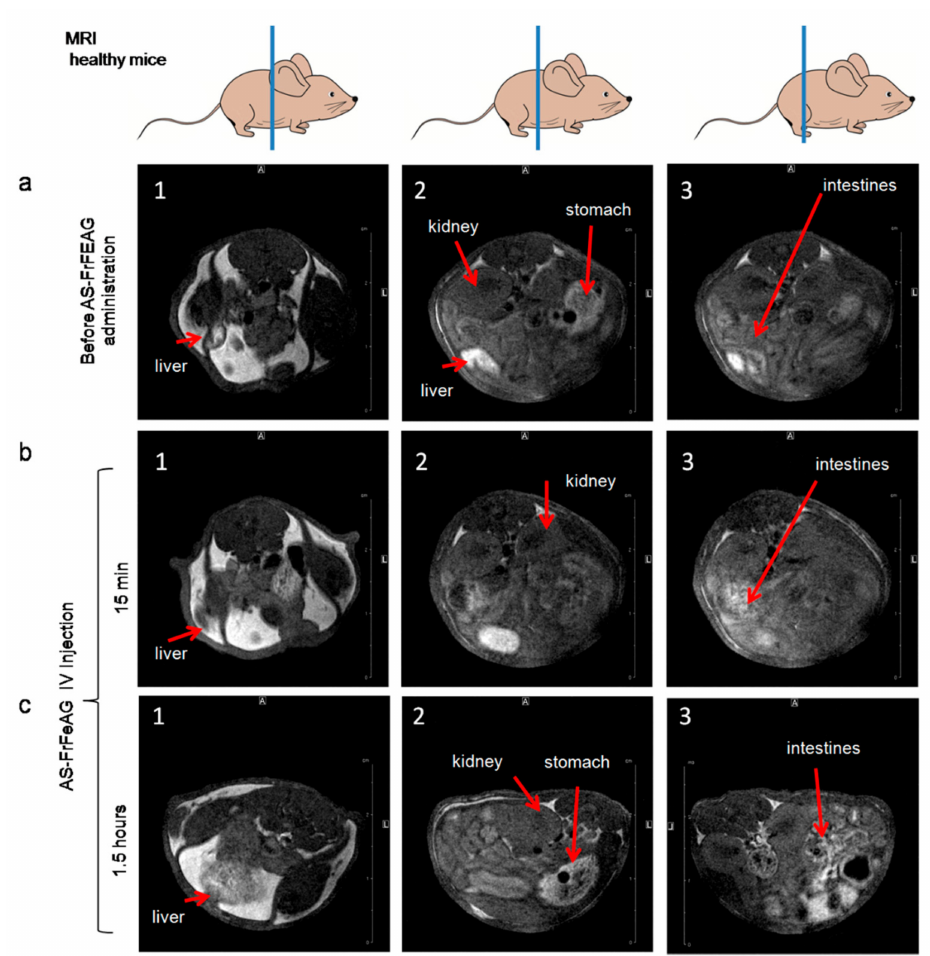
Figure 7. Distribution of AS-FrFeAG in di ff erent organs of mice analyzed by MRI before ( a ) and 15 min ( b ), 1.5 h ( c ) after the intravenous